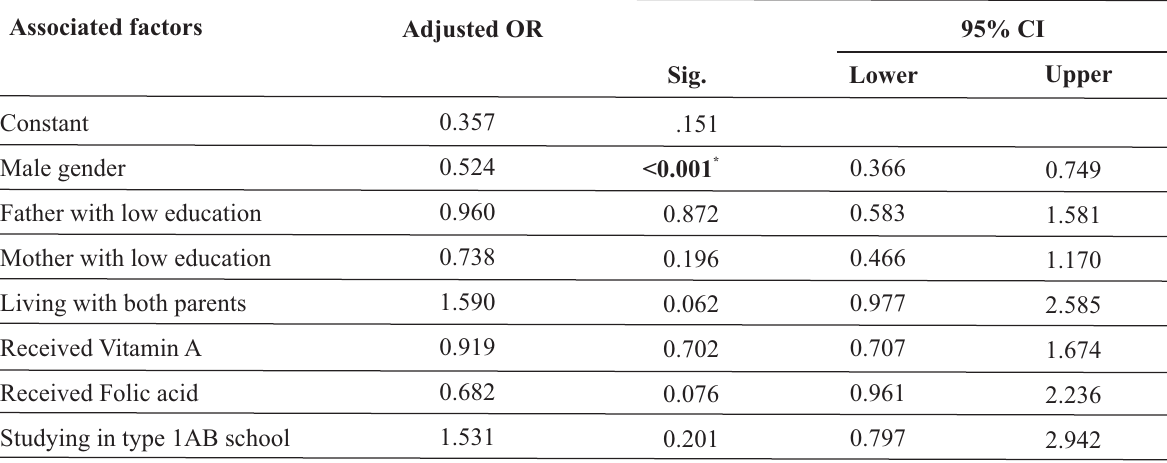
Table 5: Independent factors associated with poor mental health status based on multivariate logistic regression Associated